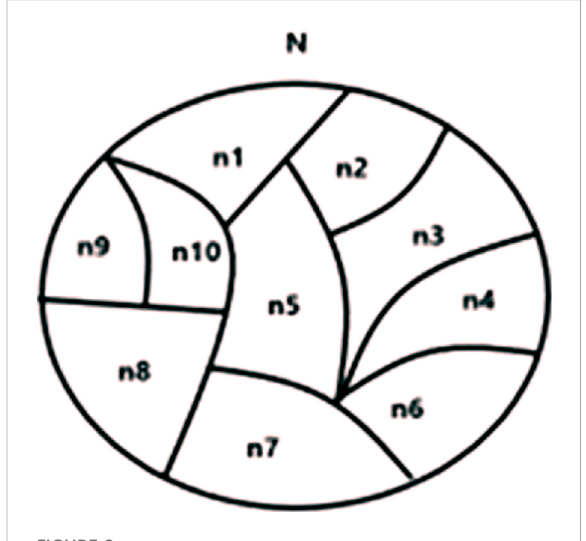
FIGURE 2 If the area chosen has a population of 5,000, the 10 strata must each have a population of about